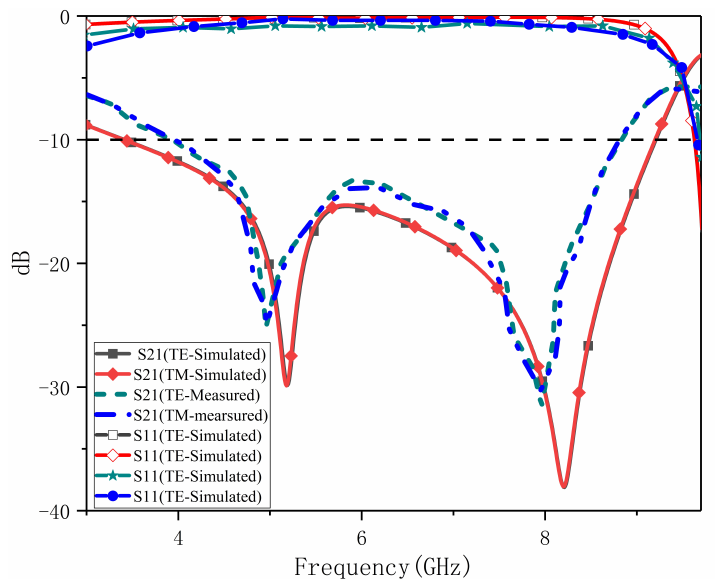
Figure 9. Photograph of the measurement system setup of the fabricated fractal FSS.